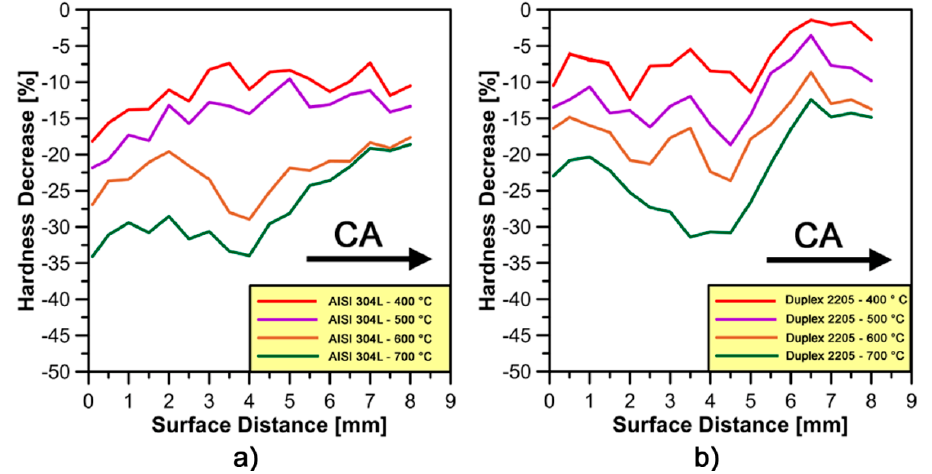
Figure 11. Average trends of microhardness decrease rate as a function of distance along the compression axis (CA) for: ( a ) AISI 304L; and ( b ) Duplex 2205 stainless steel.